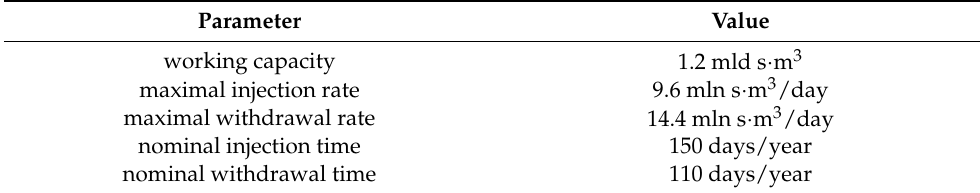
Table 1. Parameters of the analyzed storage